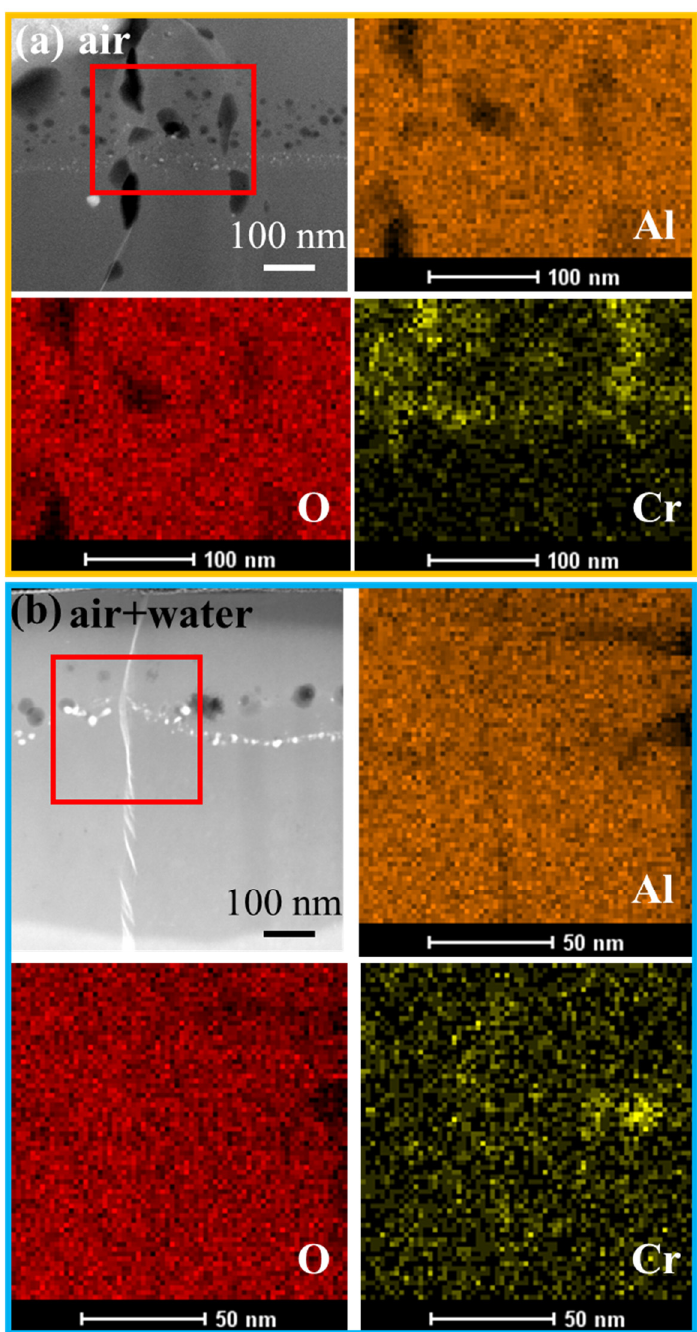
Figure 10. STEM microstructure and EDS-mapping results of the NiCrAlYHf alloy after 100 h at 1100 °C: in air ( a ) and air-water vapor ( b ). Table 3. The chemical compositions (at.%) of the points in Figure 10 by EDS.